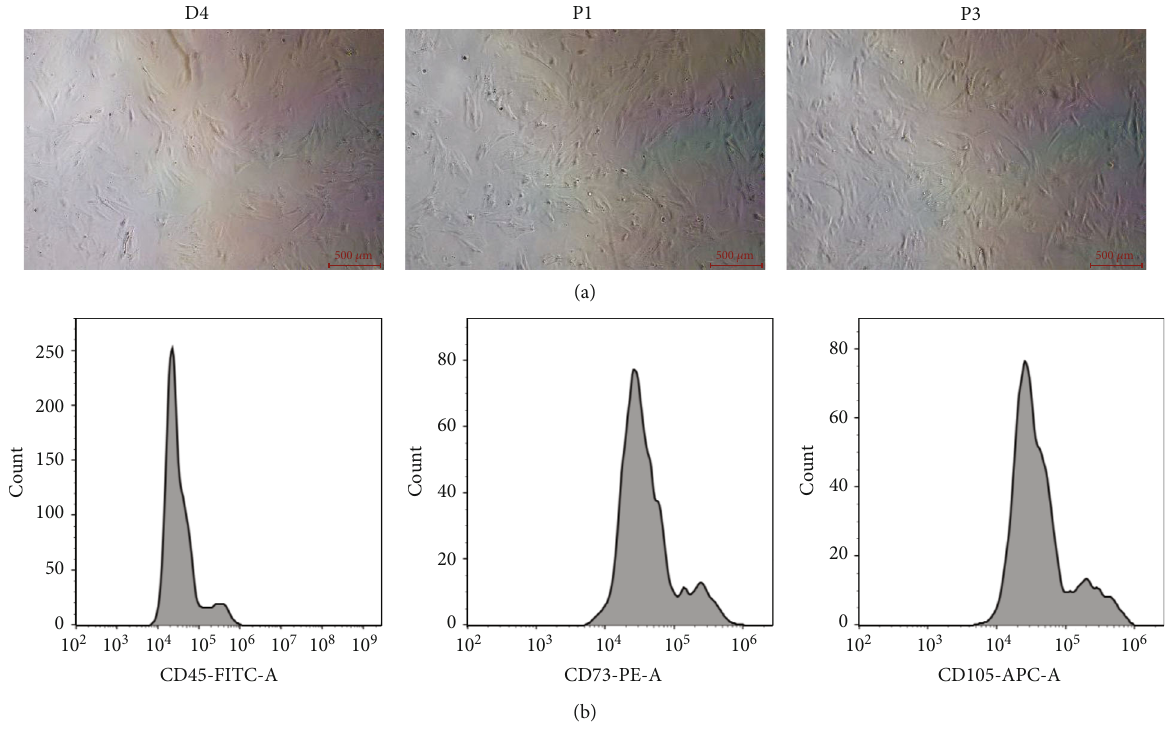
Figure 1: BMSC identi fi cation.